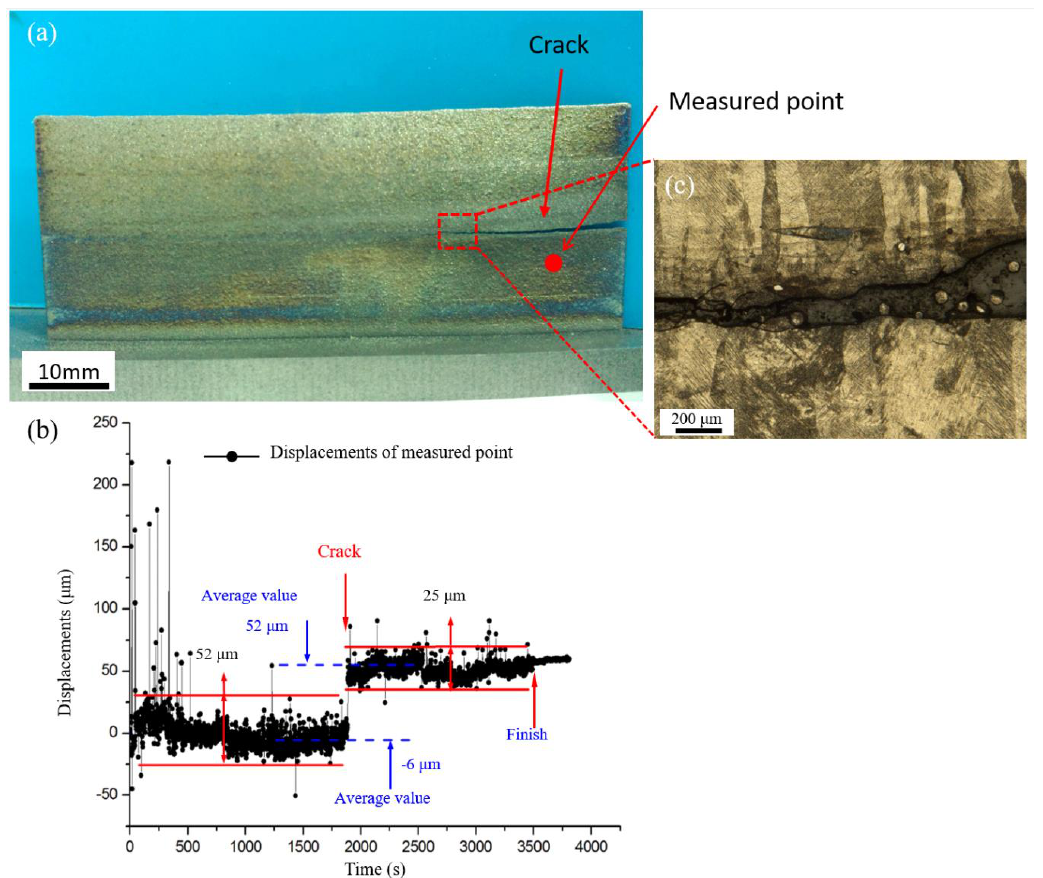
Figure 9. Monitor of the thin-wall sample deposition process with cracking: ( a ) the thin-wall sample deposited with cracking, ( b ) the real-time deformation curve at the measuring point during the deposition of the Ti-6Al-4V thin-wall sample, ( c ) observation of cracking position.